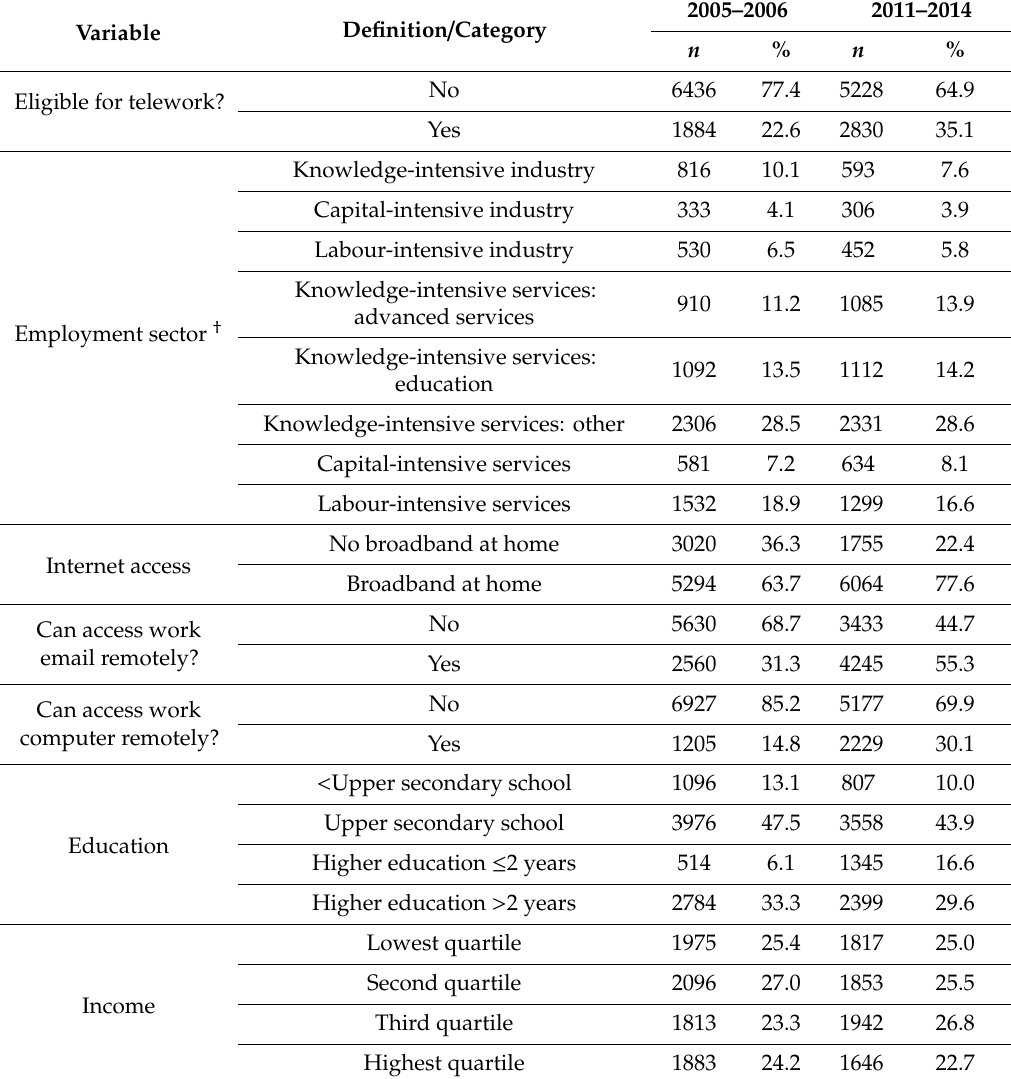
Table 1. Variable definitions and descriptive